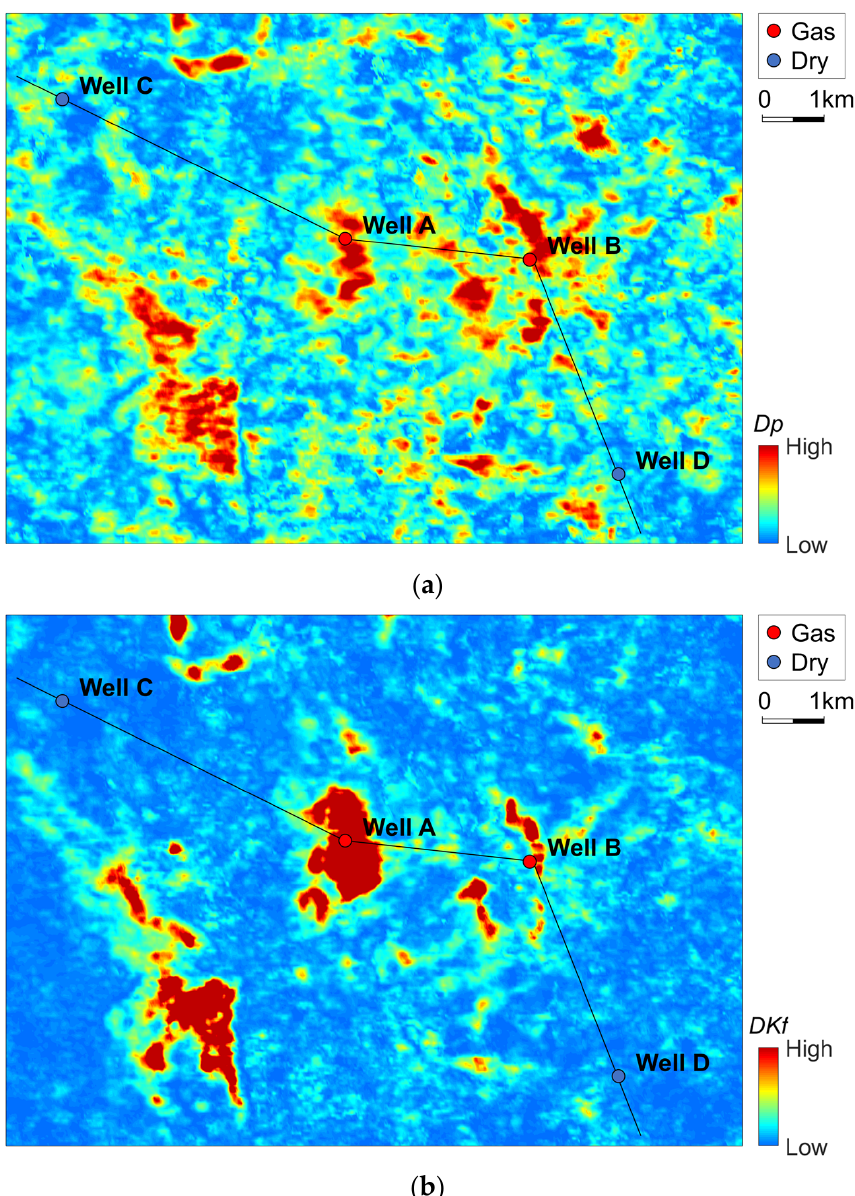
Figure 16. Horizontal slices of inverted dispersion attributes ( a ) D P and ( b ) D Kf for the target reservoir in the study area.